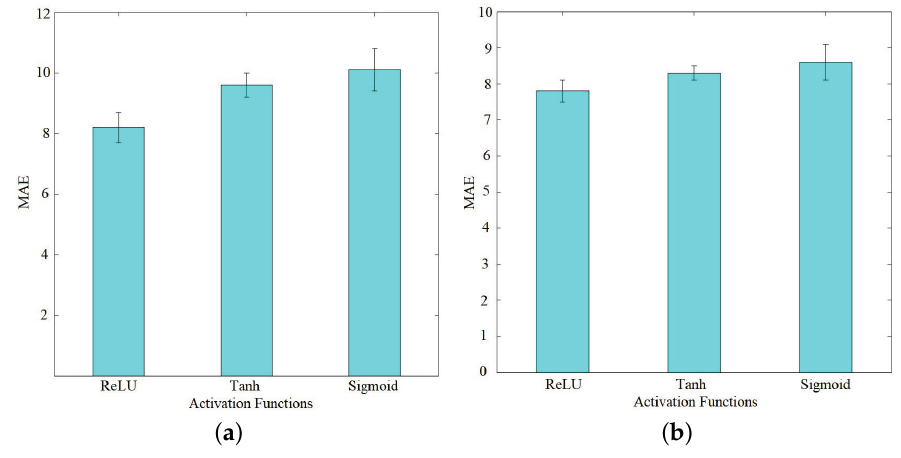
Figure 3. Different activation functions. ( a ) Results of IMDB; ( b ) Results of